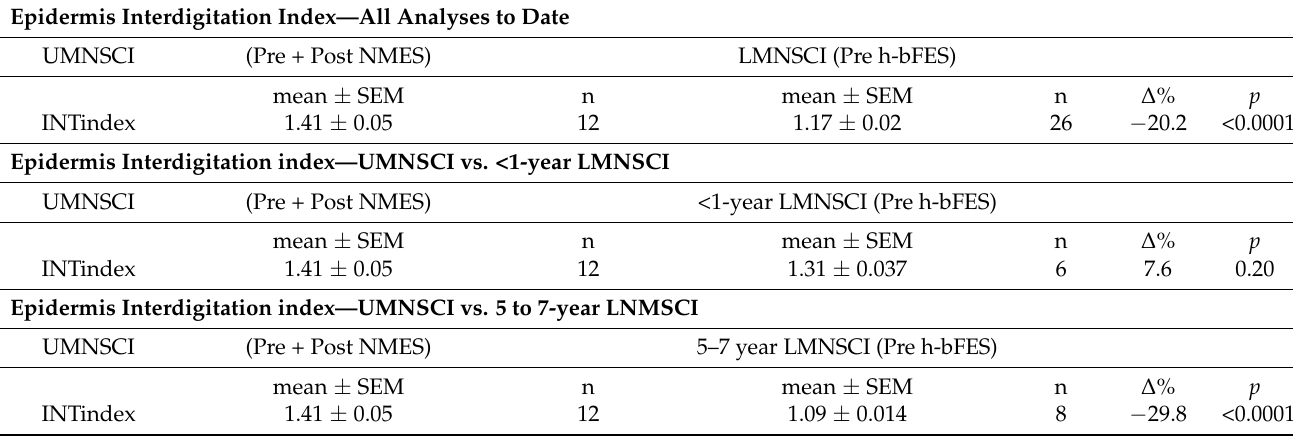
Table 6. Epidermis Interdigitation index in UMNSCI vs. LMNSCI.